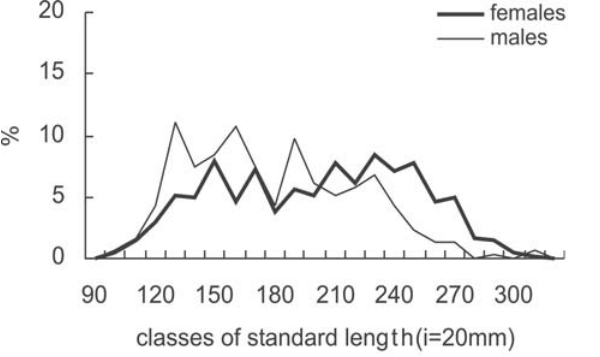
Fig.7 . Size distribution by standard length classes and sex for L. acutidens.